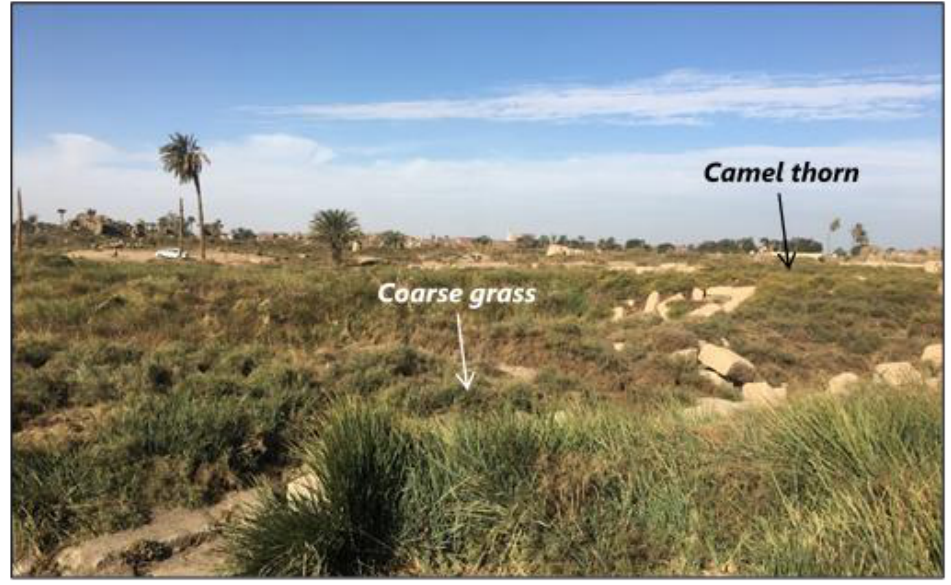
Figure 2. Different vegetation growth at the site of Hermopolis (photo taken by author).